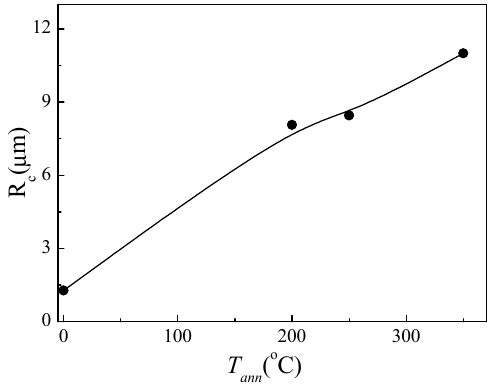
Figure 4. R c ( T ann ) dependence evaluated from hysteresis loops of studied microwire. ( T ) dependence evaluated from hysteresis loops of studied microwire. Figure 4. R c ann